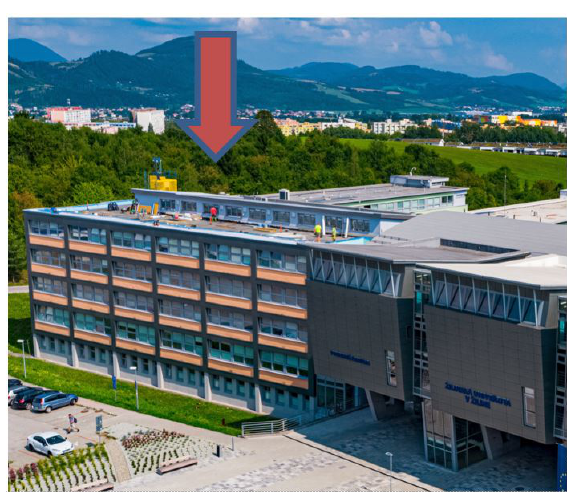
Figure 1. Aerial view during renovation work of the